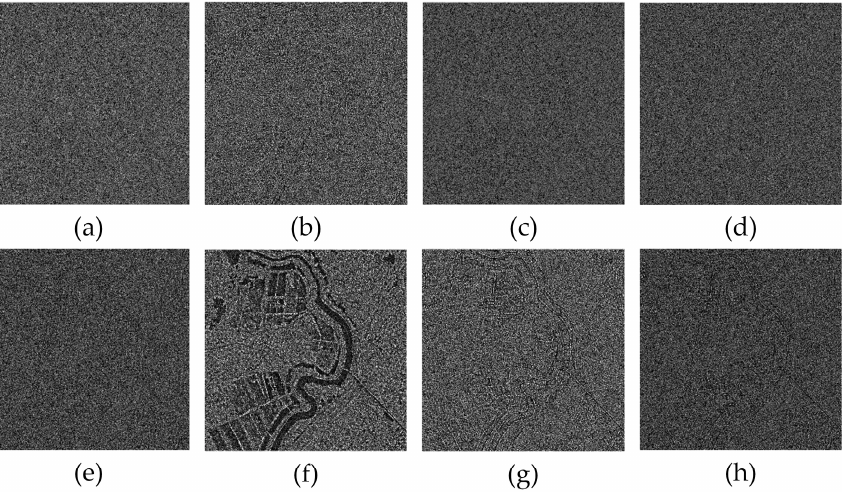
Figure 9. Ratio images between noisy and filtered GF-3 SAR images using ( a ) DPAD, ( b ) EnLee, ( c ) SAR-BM3-D, ( d ) FANS, ( e ) PPB, ( f ) DnCNN, ( g ) NL-means, and ( h ) MDLPIA-NLM filters.